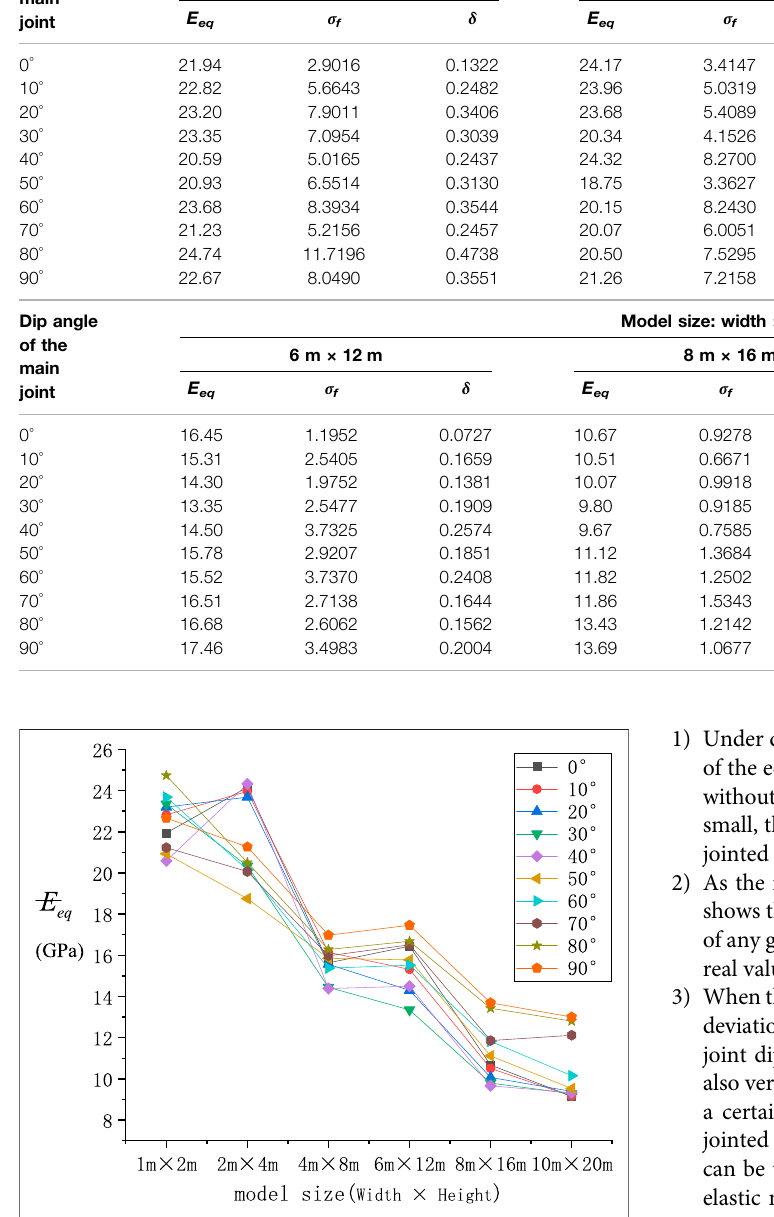
TABLE 3 | Mean elasticity moduli under different model sizes and joint angles ( σ 3 = 4 MPa). Dip angle of the